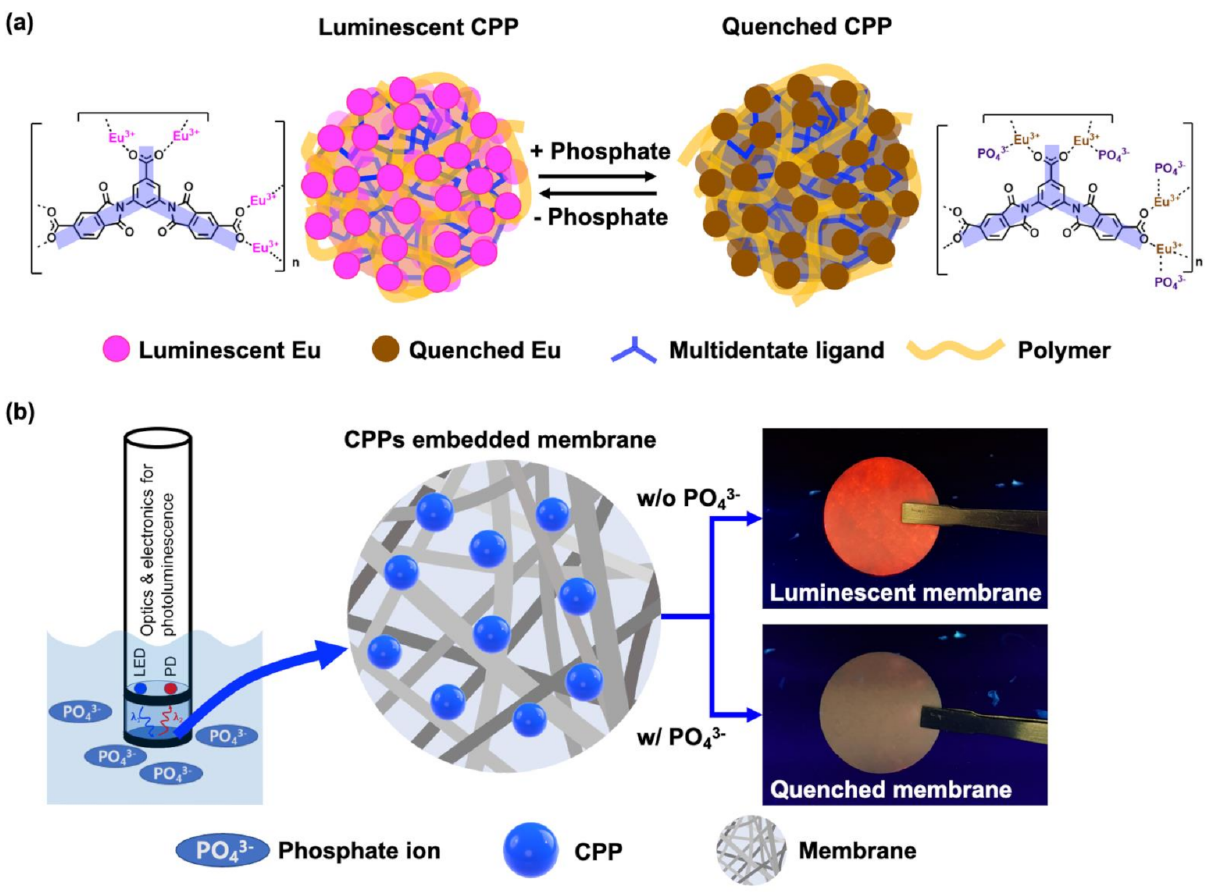
Figure 1. ( a ) Schematic illustration of the luminescent “turn-off” sensing based on CPP for detection of phosphate. ( b ) Conceptual configuration of phosphate sensor composed of light source, detector, and membrane containing CPPs as sensing